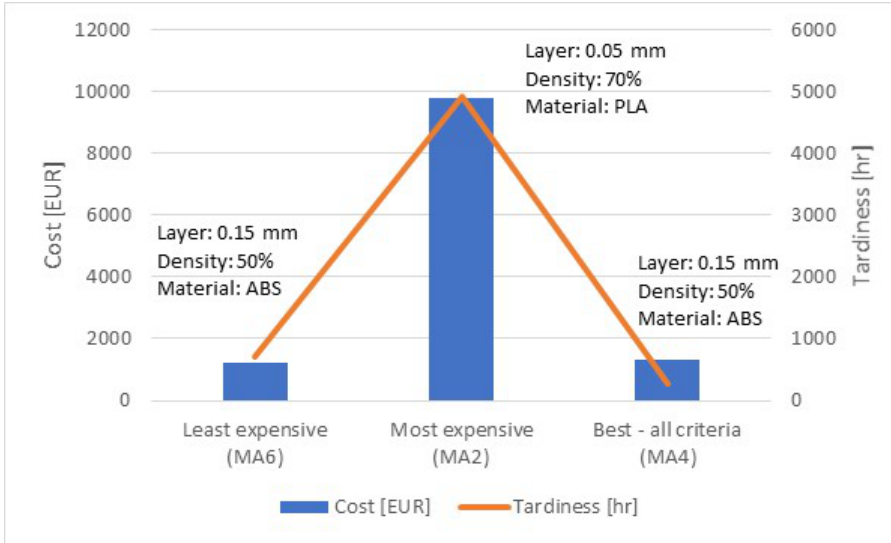
Figure 8. Test Case 1—Design Agent Graphical User Interface (GUI) with technical data and information from Machine Agents.